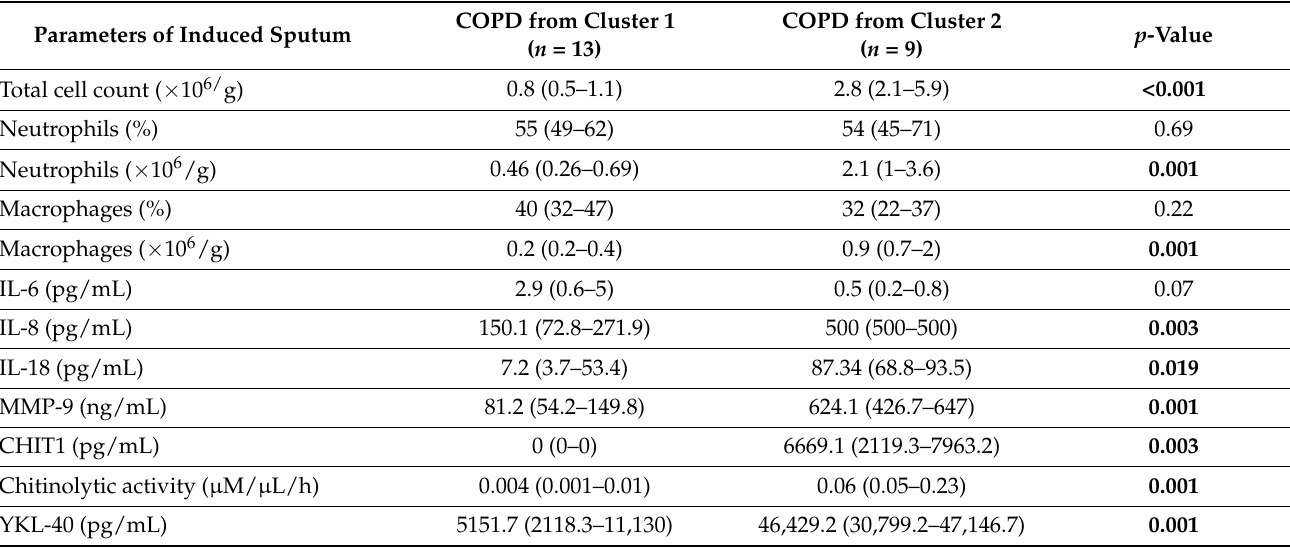
Table 7. Sputum cellular characteristics and mediator levels in COPD patients from the two identified